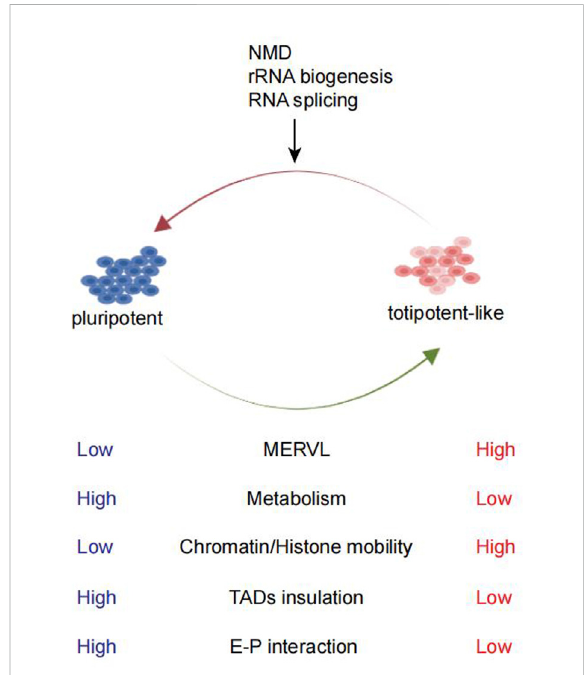
FIGURE 1 Comparison between pluripotent and totipotent-like cells and the pathways studied for totipotent-like exit. mESCs can fl uctuate in and out of a transient totipotent-like state and exhibit similarities to totipotent 2C embryos. Totipotent-like cells exhibit high MERVL expression, low metabolism, high chromatin/ histone mobility, weakening of TAD insulation, and E – P interaction. NMD, rRNA biogenesis, and RNAsplicing are shown to promote totipotent-like